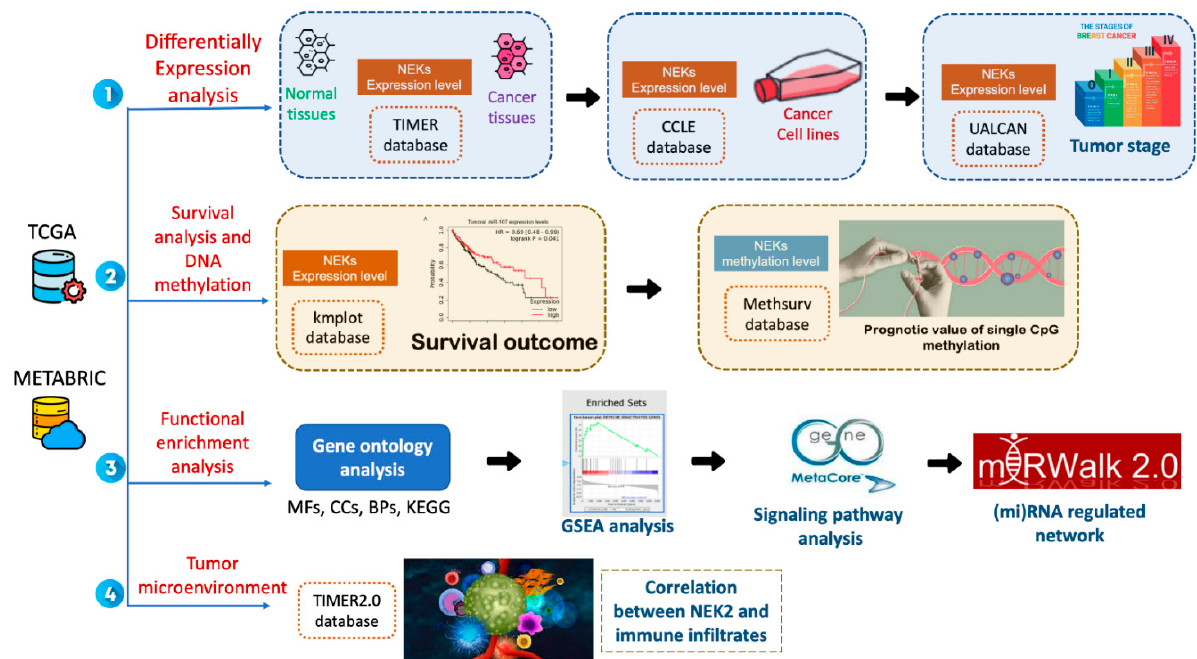
Figure 1. The workflow and study design of the analysis steps. TCGA: The Cancer Genome Atlas; METABRIC: Molecular Taxonomy of Breast Cancer International Consortium; NEK: NIMA-related kinase; GSEA: gene set enrichment analysis; BP: biological process; MF: Molecular Function; CC: Cellular Component; KEGG: Kyoto Encyclopedia of Genes and Genomes; CCLE: Cancer Cell Line Encyclopedia; MetaCore Analysis; micro (mi)RNA-regulated networks; TIMER: Tumor IMmune Estimation Resource.